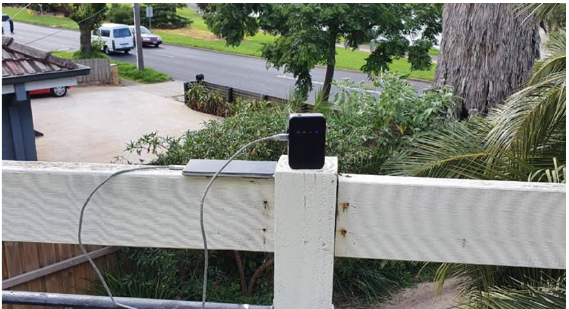
Figure 2. The Softbank GNSS QZSS enabled receiver used in the EWS trial